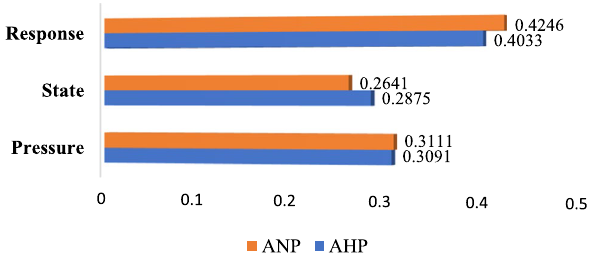
Fig. 5 eWPI main criteria weights